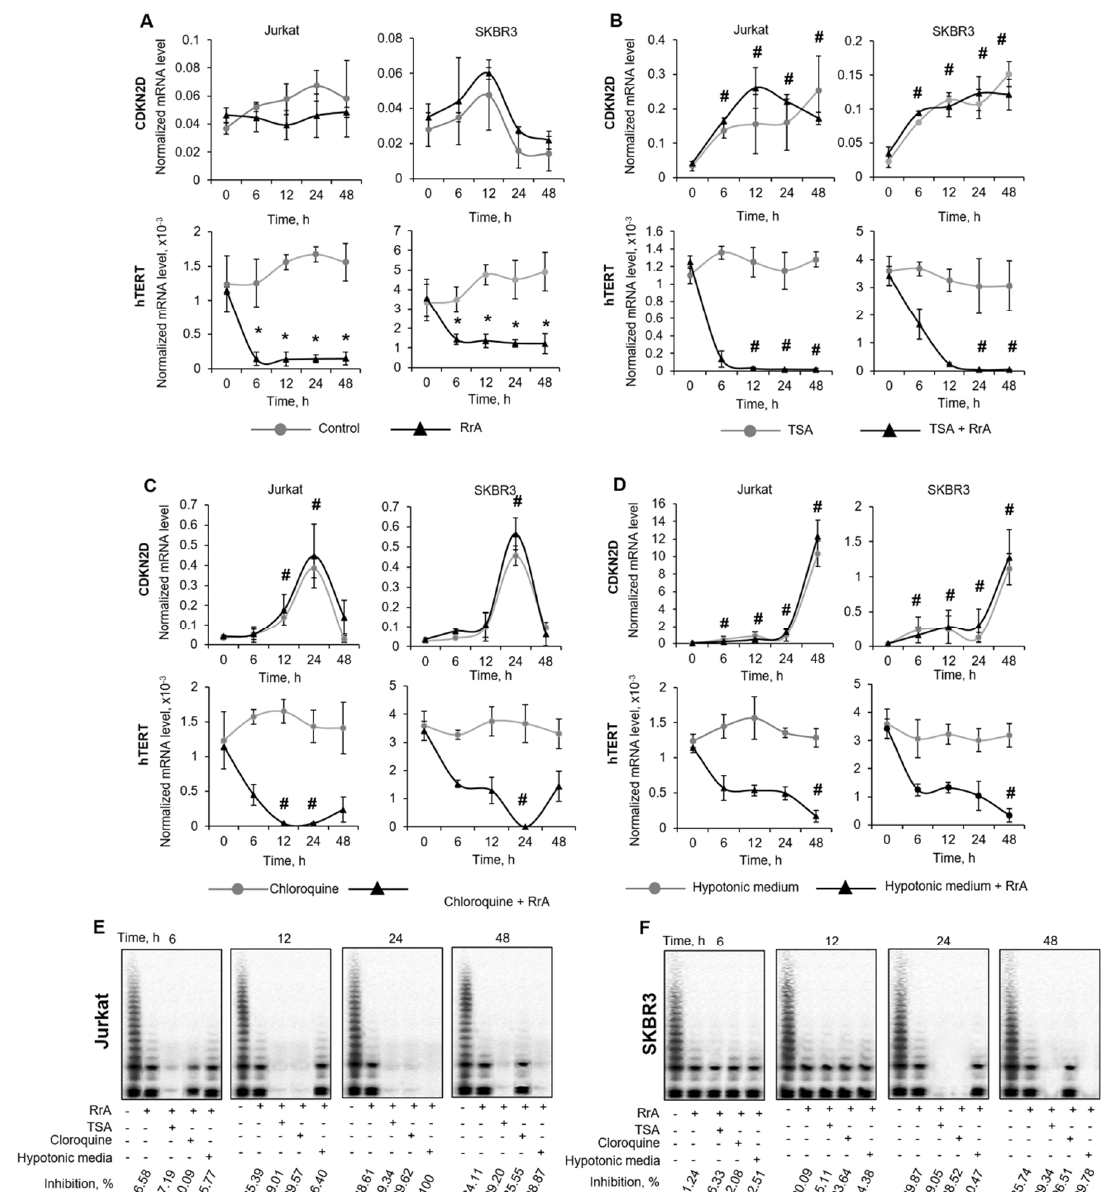
Figure 7. Chromatin relaxation increases the suppression rate of telomerase and hTERT expression by RrA. The Jurkat or SKBR3 cell lines were incubated under chromatin-modifying conditions in the presence of RrA. CDKN2D (marker of chromatin relaxation) and hTERT mRNA expression levels normalized relative to the expression of the reference gene 18S in ( A ) control Jurkat or SKBR3 cells; ( B ) cells treated with TSA; ( C ) cells treated with chloroquine or ( D ) cells grown in hypotonic medium. Representative TRAP gel electrophoresis and percent of inhibition of telomerase activity in ( E ) Jurkat or ( F ) SKBR3 cells. Percent of telomerase inhibition is calculated relative to untreated control cells. N = 4. RrA, Rhodospirillum rubrum L-asparaginase. TSA, trichostatin A. * p ≤ 0.05 vs. cells control untreated cells. # p ≤ 0.05 vs. cells incubated with RrA.